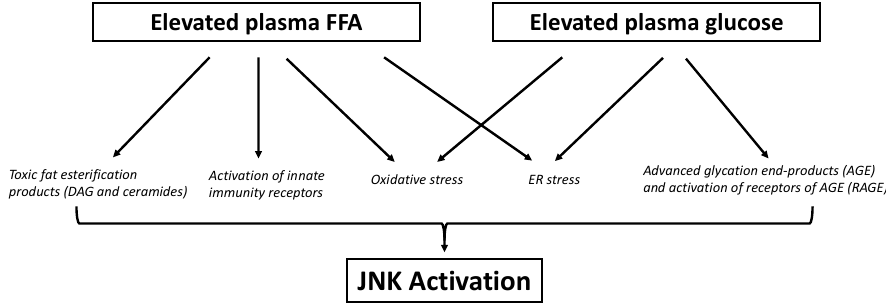
Figure 3. Various mechanisms have been proposed to cause JNK activation during obesity and T2D. Both elevated plasma free fatty acids (FFA) and glucose can accumulate and negatively impact tissues (e ff ects known as lipotoxicity and glucotoxicity, respectively), via JNK activation. Excess FFA can overload the oxidative capacity of cells, leading to incomplete oxidation of FFA, which not only generates reactive oxygen species (ROS), but also causes accumulation of lipotoxic esterification products such as diacylglycerol (DAG) and ceramides. DAG can activate JNK via PKC and ROS, while ceramides can activate JNK via ASK1 or via inhibiting sarco(endo)plasmic reticulum Ca 2 + -ATPase pump (SERCA) to induce ER stress. Saturated FFA can reduce membrane fluidity, which inhibits SERCA to cause ER stress, which in turn activates JNK via IRE1 α . Saturated FFA can also activate JNK through receptors of the innate immune system, such as TLRs and NOD receptors. Excess glucose can similarly overload mitochondrial oxidative capacity, which elevates ROS production. Glucose can also undergo non-enzymatic glycosylation reactions to form advanced glycation end products (AGE), and this process also produces ROS. AGE can bind to receptors of AGE (RAGE) to initiate inflammatory processes. Both oxidative stress and AGE can induce ER stress, and ultimately activate